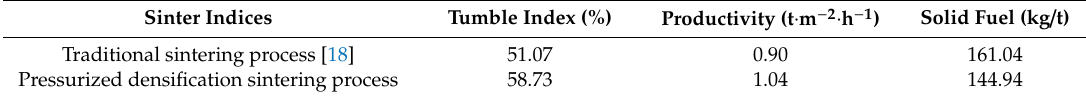
Table 8. Anticipated techno-economic benefits of pressurized densification sintering